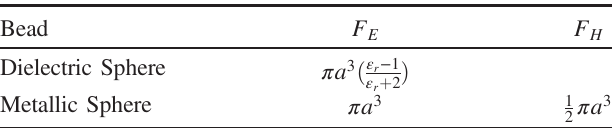
TABLE IV. Perturbation factors for sphere (radius ¼ a). Bead